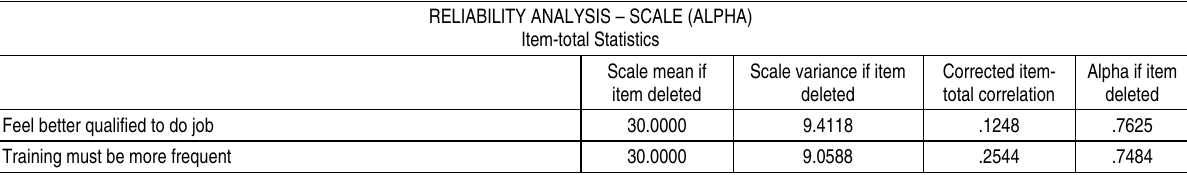
Table 2. Reliability analysis of “organizational commitment” measuring instrument RELIABILITY ANALYSIS – SCALE (ALPHA) Item-total